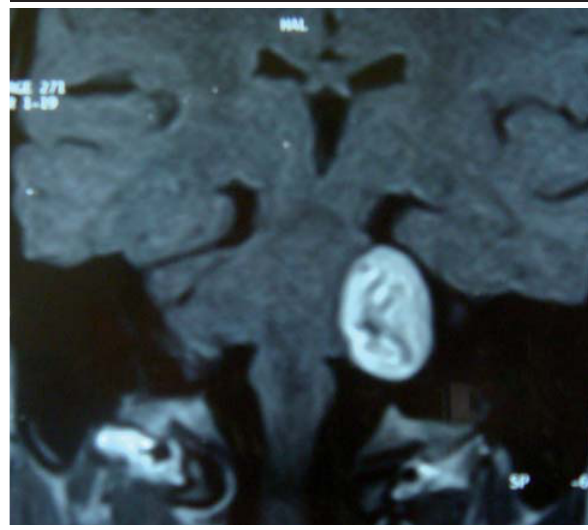
Figure 1. Pre-operative Pure Tone Audiogram; unmasked (x) and masked (])